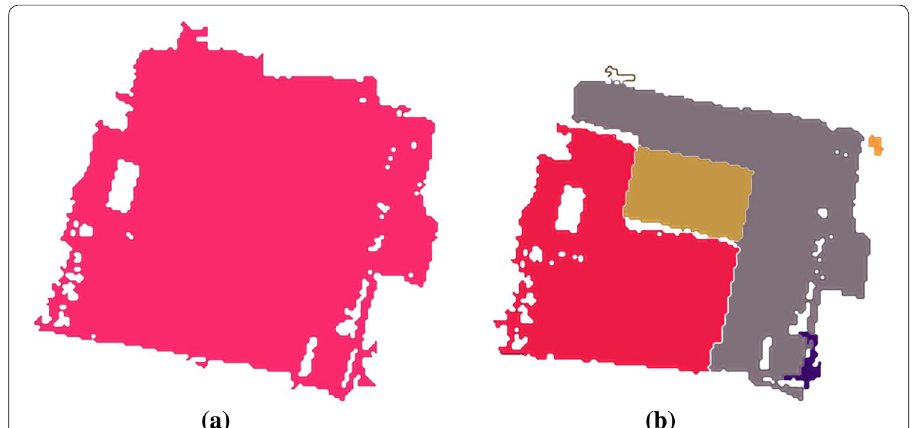
Fig. 6 Illustration of the Intersection Over Union (IOU) of a building. a The Real Building. b Segmentation Prediction of a Building